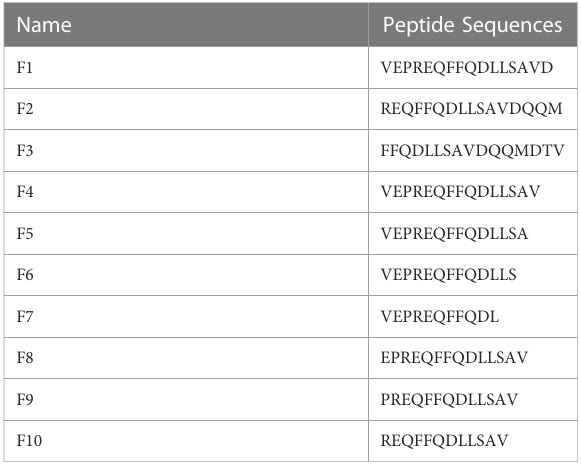
TABLE 2 Sequences of peptides synthesized in this